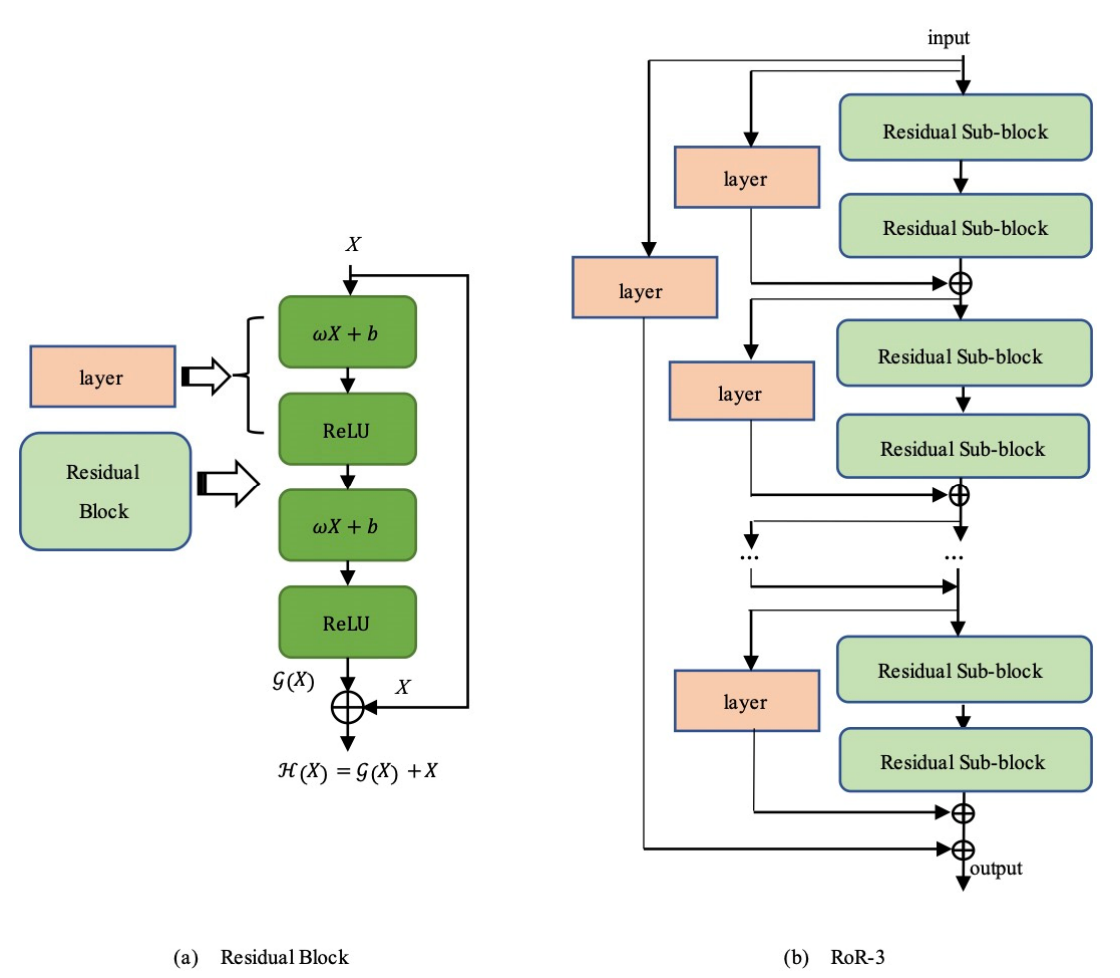
Figure 5. ( a ) The residual block (ReLU is adopted as an activation function in each hidden layer). ( b ) RoR-3 has a three-level shortcut.